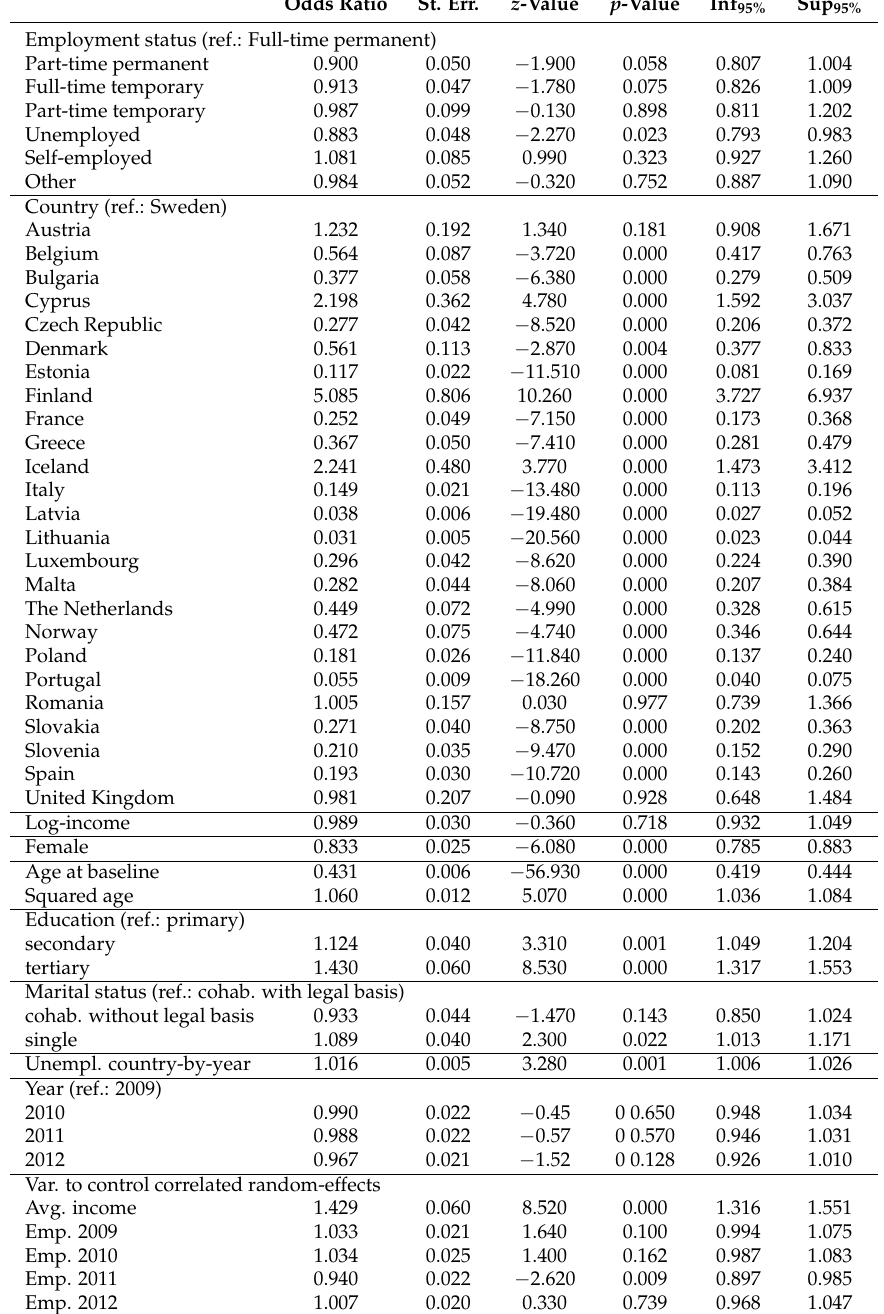
Table 6. Correlated random-effects ordered logit model for with economic deprivation —All countries (Log-likelihood = − 71,673.350 ; ICC = 0.532; AIC = 143,488.7; BIC = 144,070.89). Odds Ratio St. Err. z -Value p -Value Inf 95% Sup 95% Employment status (ref.: Full-time permanent) Part-time permanent 0.900